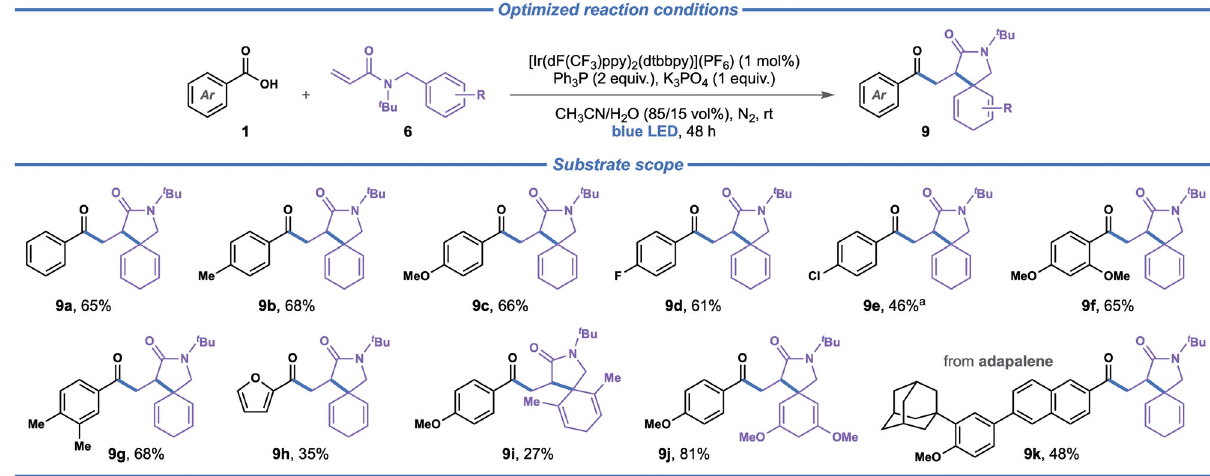
Fig. 5 The scope for intermolecular radical dearomative spirocyclization. Reaction conditions: carboxylic acid (0.2 mmol, 1 equiv.), acrylamide acceptor (2 equiv.), triphenylphosphine (2 equiv.) K 3 PO 4 (1 equiv.), [Ir(dF(CF 3 )ppy) 2 (dtbbpy)](PF 6 ) (1 mol%), CH 3 CN/H 2 O (85:15 vol%, 4 mL), N 2 , blue LEDs (440 nm), 48 h, fan cooling (35 – 40 °C). a carboxylic acid (2 equiv.), acrylamide acceptor (0.2 mmol, 1 equiv.).